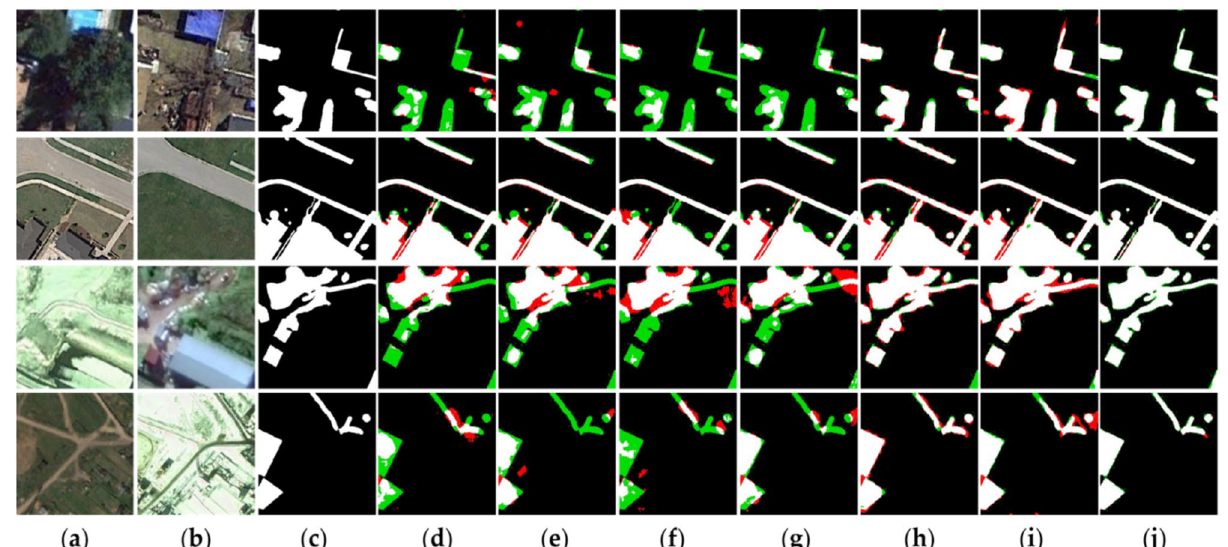
Figure 5. Bi-temporal remote sensing images from CDD dataset. The ( a ) are change before images; the ( b ) are change after images; the ( c ) represents the changed areas and the unchanged areas; ( d ) are results obtained by CDNet; ( e ) are results obtained by FC-EF; ( f ) are results obtained by FC-Siam-Diff; ( g ) are results obtained by FC-Siam-Conc; ( h ) are results obtained by DASNet; ( i ) are results obtained by STANet; ( j ) are results obtained by MFPF-Net (created by ‘Microsoft Office Visio 2013’ url: https:// www. micro soft. com/ zh- cn/ micro soft- 365/ previ ous- versi ons/ micro soft- visio-